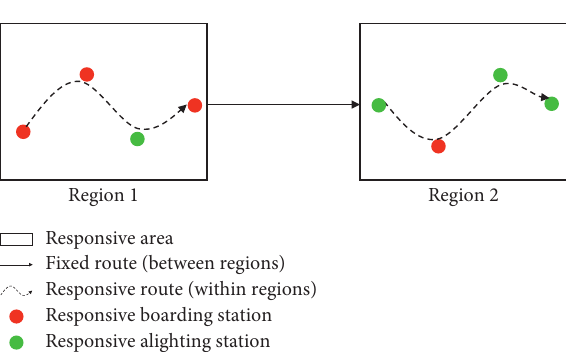
Figure 2: Operation of the regional flexible